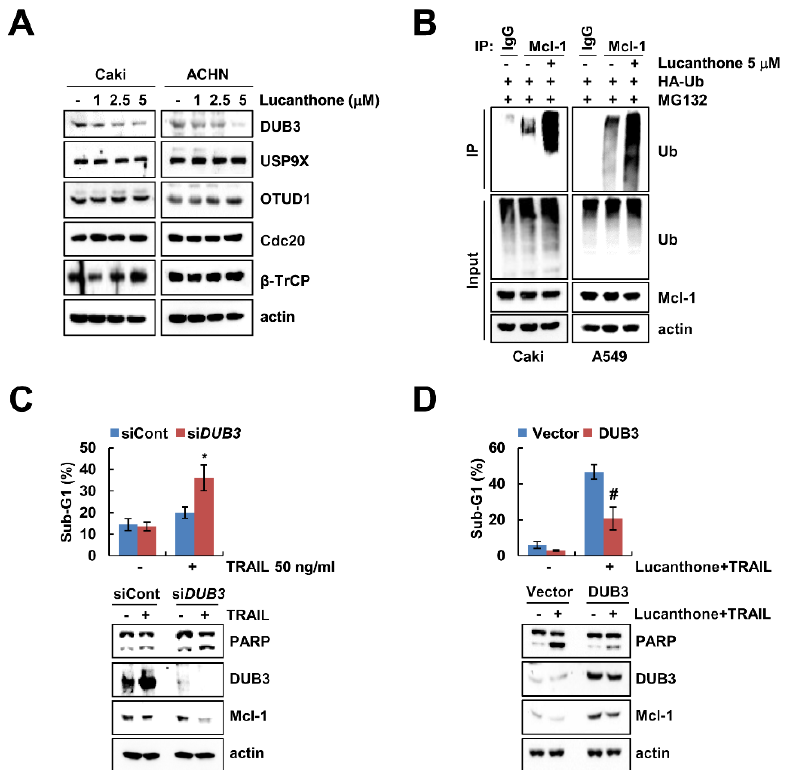
Figure 4. Lucanthone-induced DUB3 downregulation contributes to TRAIL sensitization. ( A ) Caki and ACHN cells were treated with the 1–5 µ M lucanthone for 24 h; ( B ) Caki cells were transfected with HA-ubiquitin (HA-Ub) plasmid for 24 h. Then cells were treated with 0.5 µ M MG132 and 5 µ M lucanthone for 24 h. Mcl-1 ubiquitination was detected by Western blotting using HRP-conjugated anti-Ub antibody; ( C ) Caki cells were transfected control siRNA (siCont) or DUB3 siRNA (si DUB3 ), and then treated with 50 ng/mL TRAIL for 24 h; ( D ) Caki cells were transfected with pcDNA3.1(+) (Vector) or pcDNA3.1(+)/DUB3 plasmids, and then treated with combinations of 5 µ M lucanthone with 50 ng/ml TRAIL for 24 h. ( A – D ) The protein expression and ( C , D ) sub-G1 population were measured by Western blotting and flow cytometry, respectively. The values in graph represent the mean ± SD of three independent samples. * p < 0.05 compared to TRAIL in siCont-transfected cells. # p < 0.05 compared to the combinations of lucanthone and TRAIL in vector-transfected cells.